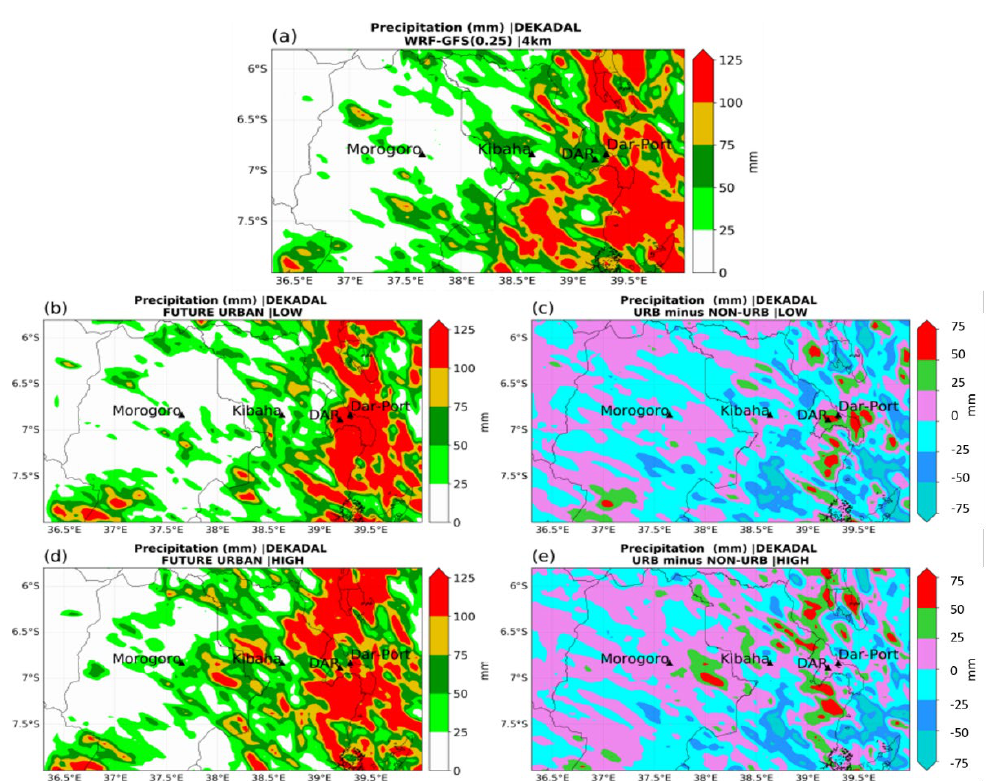
Figure 5. Spatial distribution of period averaged total precipitation for ( a ) current LULC, ( b ) low-urbanization, ( d ) high-urbanization scenarios, and their differences (urbanized–current) between the current LULC and ( c ) low urbanized and ( e ) high urbanized scenarios.